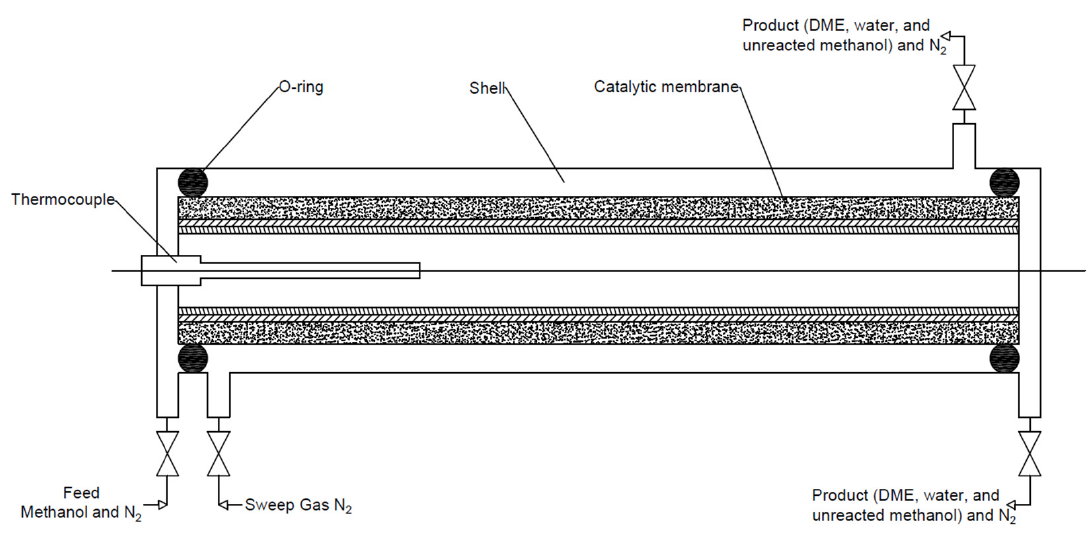
Figure 14. Tubular membrane reactor. Developed based on [1] (c) Microstructural reactors